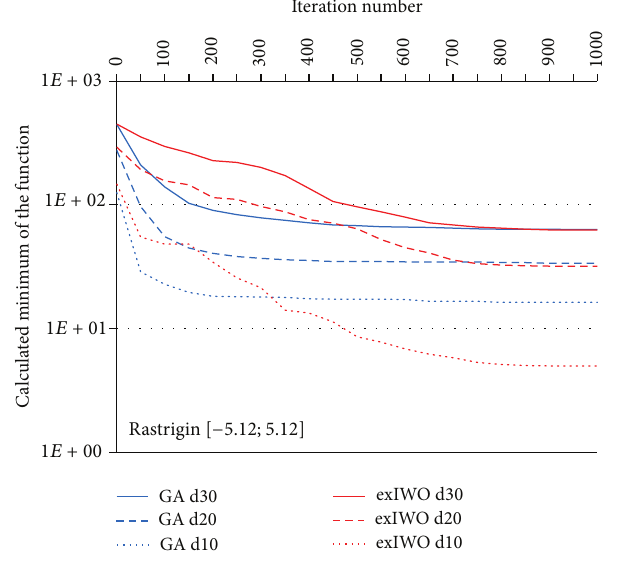
Figure9:GAandexIWO(globalselection)convergenceplotforthe Rastrigin function.